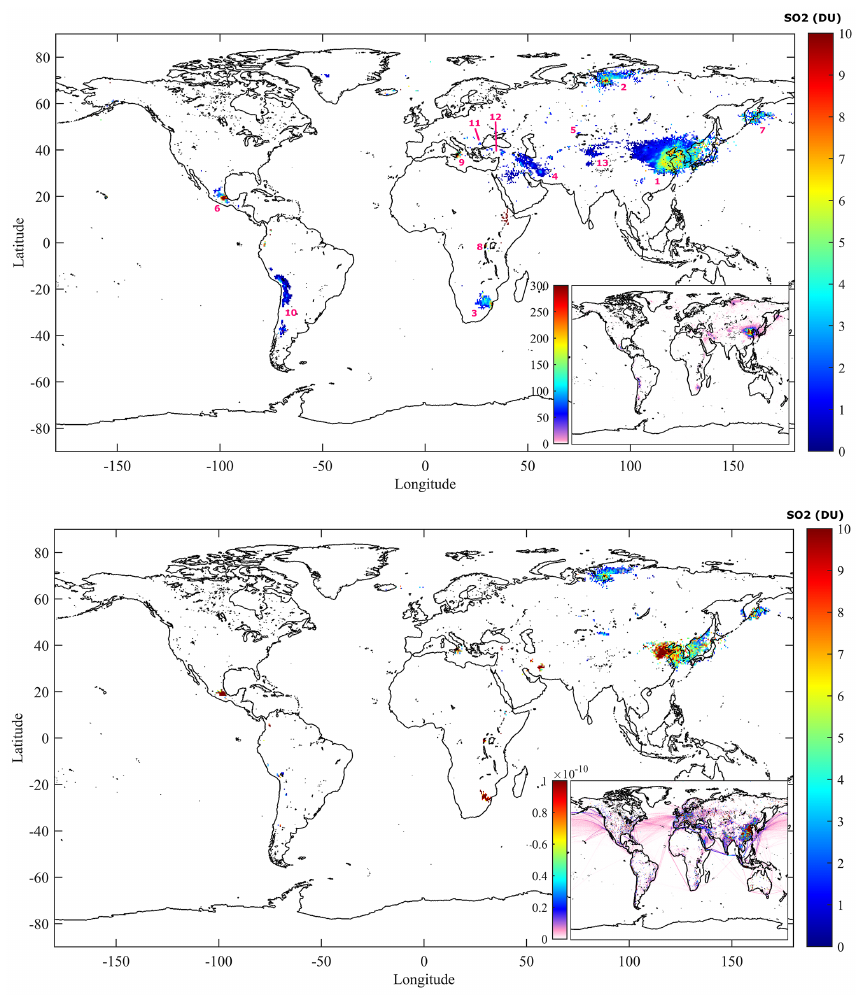
Figure 6. Averaged global distribution of near-surface SO 2 columns for the period 1 January 2008–30 September 2014. The top panel corresponds to daytime measurements and the bottom panel corresponds to night-time measurements. The bottom-right inset in the daytime map represents the total number of successful measurements (those which pass the error filtering) in each grid box. The bottom-right inset in the night-time map represents the global anthropogenic emissions (kgs − 1 m − 2 ) of SO 2 provided by the EDGARv4.2 inventory. Different sources are numbered and discussed in the text. Note that because of the error filtering, the presented global averages are biased high. They can be seen as an average of measurements which are sensitive to near-surface SO 2